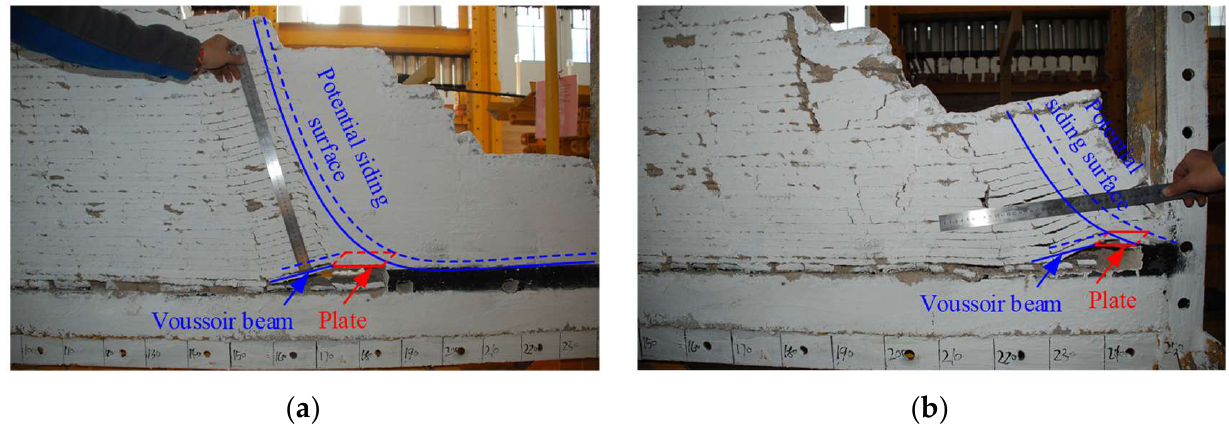
Figure 16. “Voussoir beam–plate–slip surface” structure model. ( a ) Advancing distance = 170 cm; ( b ) advancing distance = 230 cm.